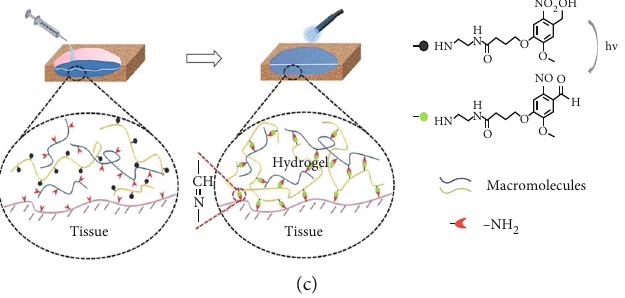
Figure 2: Adhesive hydrogels for improving the persistence of MSCs in the host. (a) Mussel-inspired tissue-adhesive cell carriers; (b) assessment of mussel-inspired tissue-adhesive cell carriers used in cartilage regeneration; (c) phototriggered tissue-integrable hydrogel developed for prolonging stem cell retention in situ. Reproduced with permission [18,